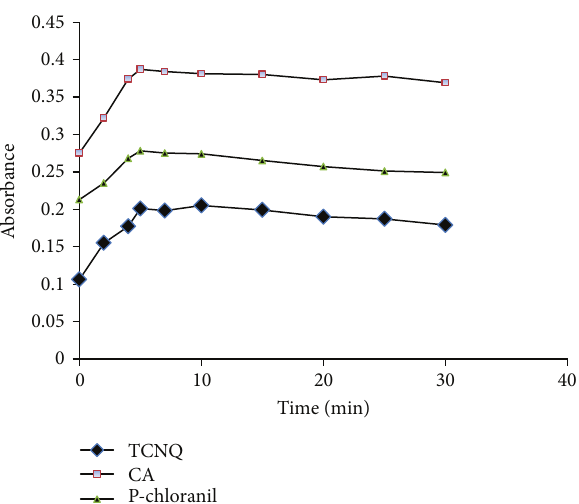
Figure 3: Effect of volumes of the reagents used for method A (CA [0.1%, w/v]), B (p-chloranil [1%, w/v]), and C (TCNQ [0.2%, w/v]) with the drug substance concentration is 150 𝜇 gmL −1 , 75 𝜇 gmL −1 , 350 𝜇 gmL −1 for methods A, B, and C, respectively.